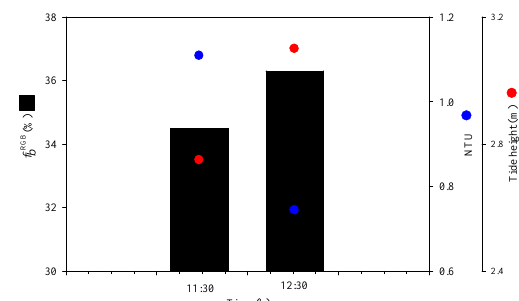
Figure 5. Proportion of bottom-derived radiance as a function of water turbidity and tide height Measurements of a CDOM at 412 nm were fairly constant during the time series (0.04 – 0.001 m -1 = arithmetic average – 2 standard errors) suggesting that light attenuation was mainly determined by suspended particulates. Thus, NTU was a good indicator of water transparency changes in our study.